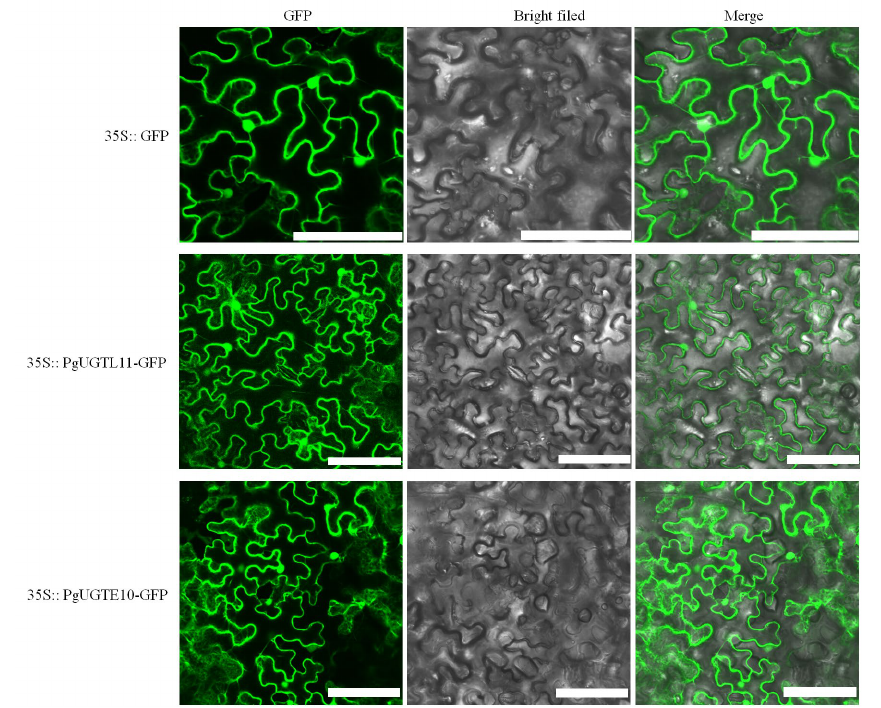
Figure 8. Subcellular localization of PgUGTL11 and PgUGTE10 in tobacco epidermal cells. Scale bar, 100 μm.